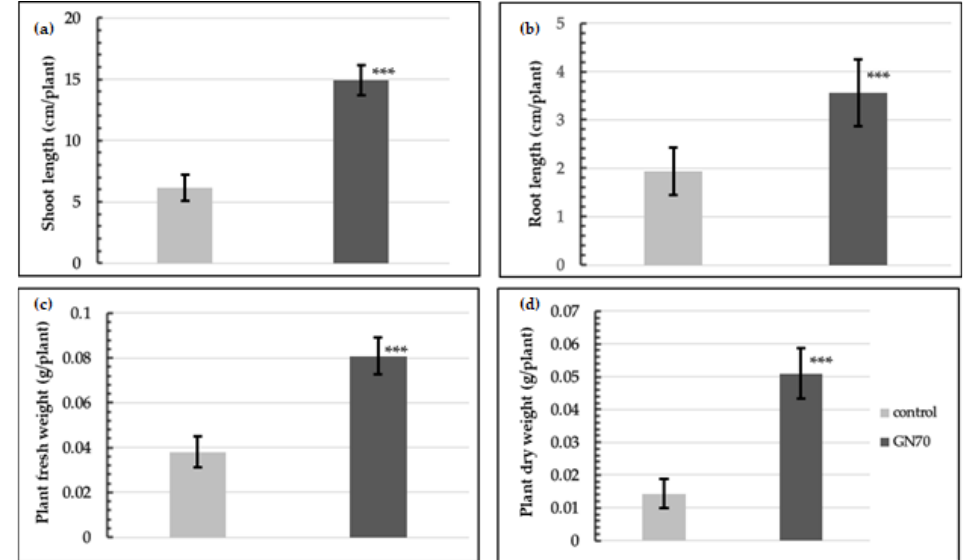
Figure 5. Effect of GN70 inoculation on rice seeds (IT267968) in pot experiment in green house after 4 weeks of growth. On average, shoot length ( a ) and root length ( b ) increased by 143.5% and 83.5%, respectively. Fresh plant biomass ( c ) increased by 112.1% and dry plant biomass ( d ) by 253.2% (average from 60 explants ± SD, *** p ≤ 0.01).